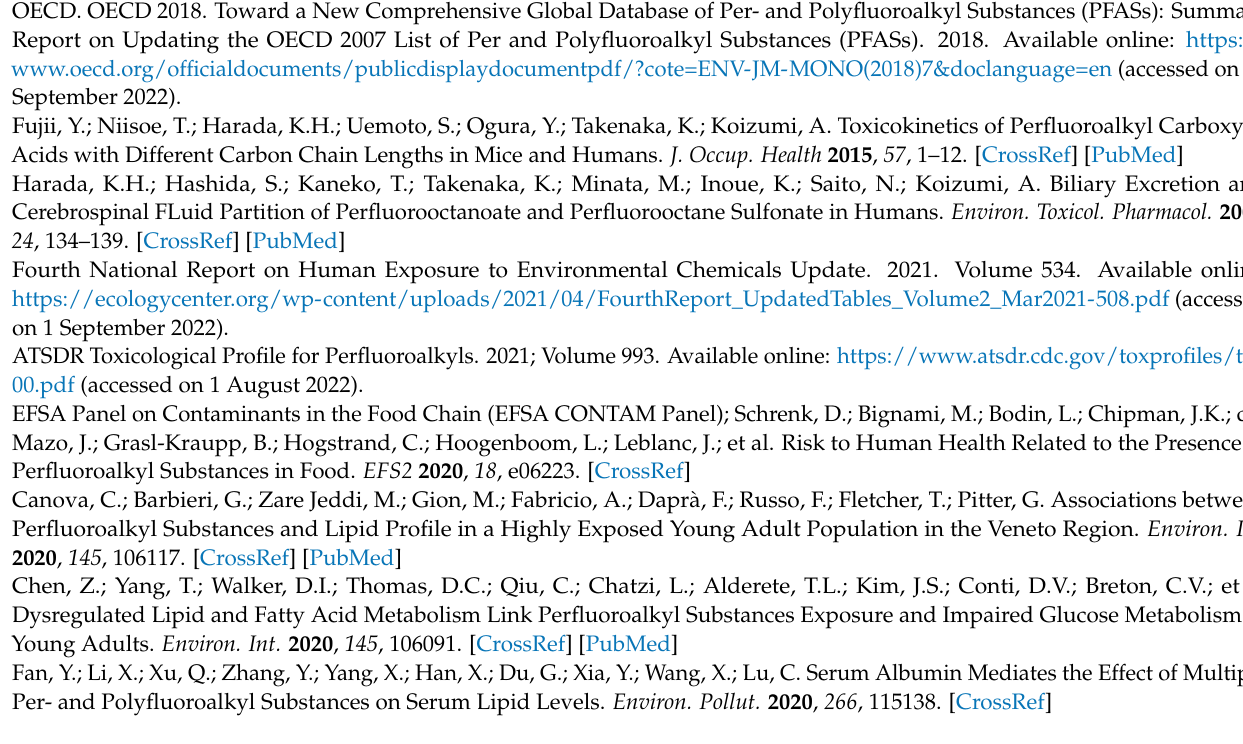
Table S8: Posterior inclusion probability of each PFAS, stratified by